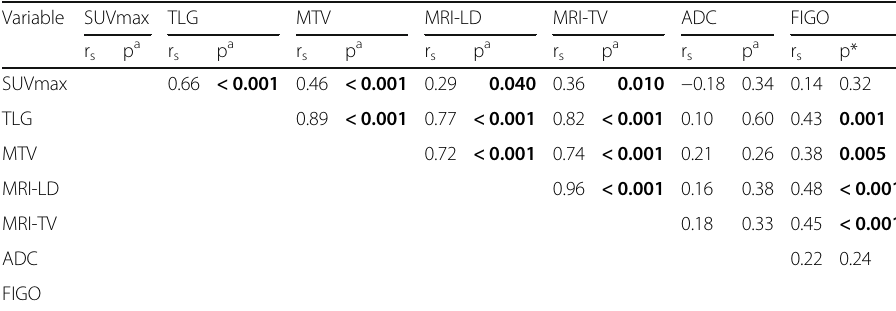
a Spearman ’ s bivariate correlation test Significant p values (<0.05) are given in bold ADC Apparent diffusion coefficient, FIGO International Federation of Gynaecology and Obstetrics, MRI-LD Longest diameter of the tumour measured by magnetic resonance imaging, MRI-TV Tumour volume measured by magnetic resonance imaging, MTV Metabolic tumour volume, SUVmax Maximum standardised uptake value and TLG Total lesion